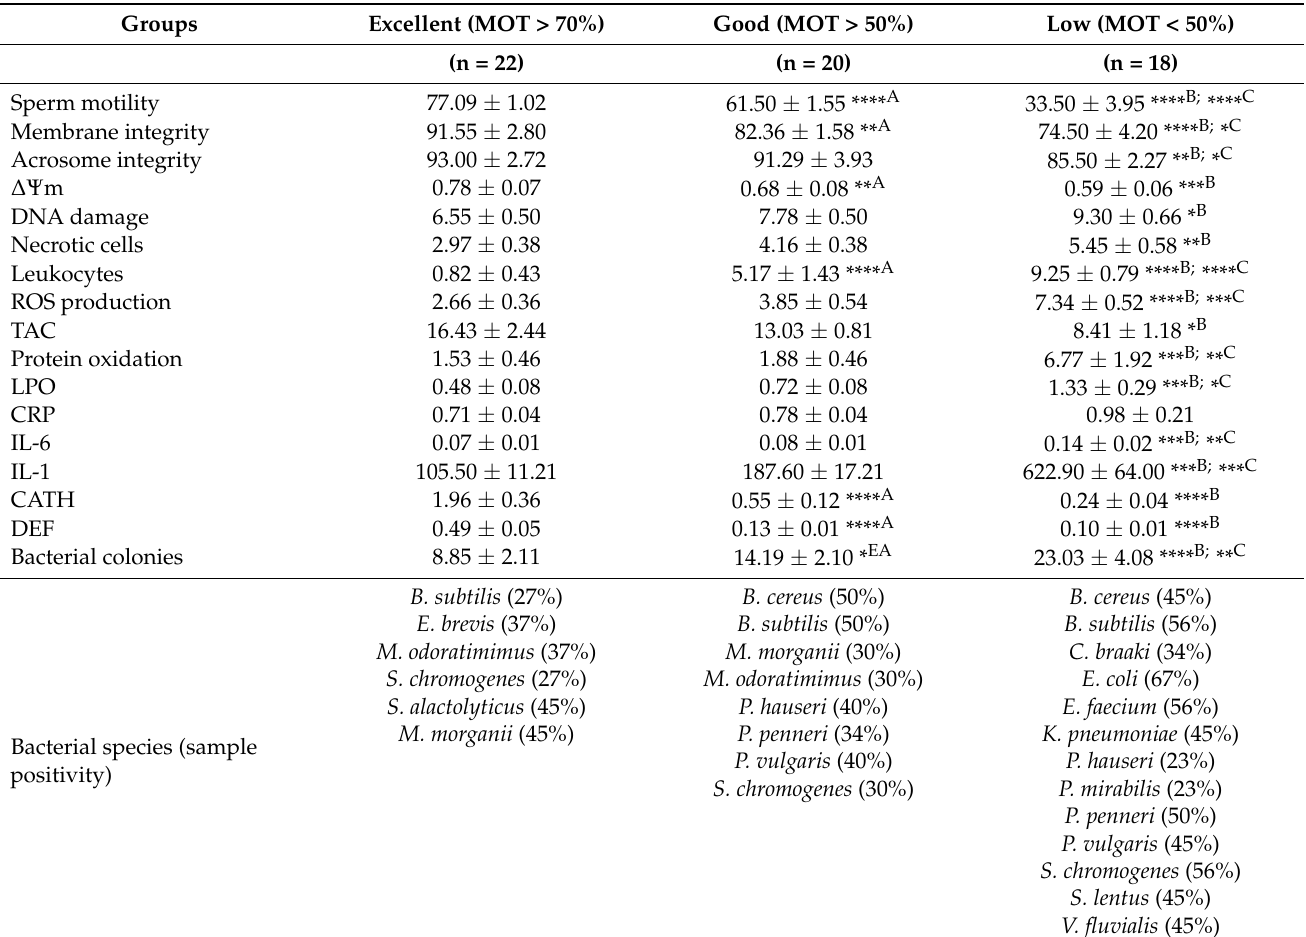
Table 4. Comparative analysis of the quality